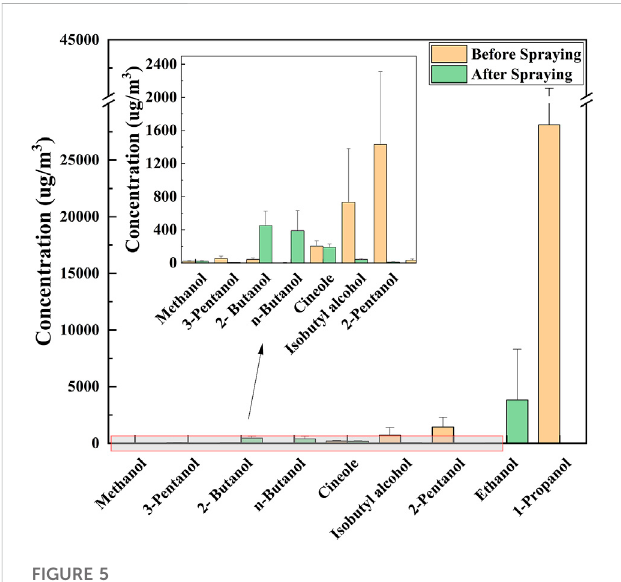
FIGURE 3 Changes in carbonyl compounds before and after spraying.